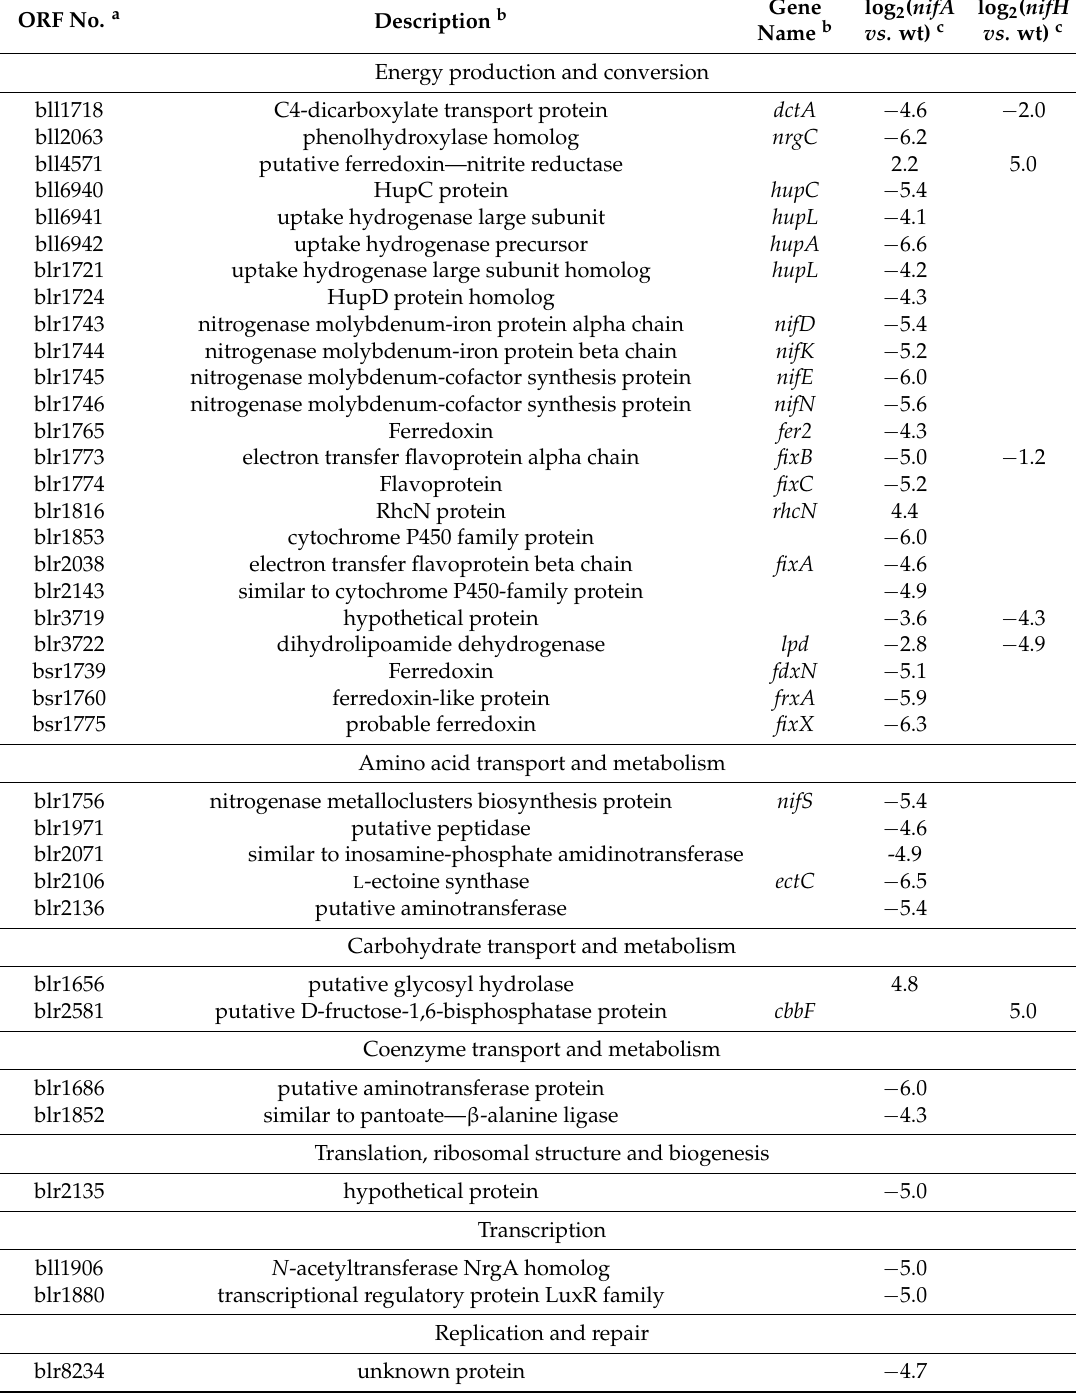
Table 3. List of the 137 genes that showed high differential expression in nodules infected by a nifH and/or a nifA mutant strain when wild-type nodules were used as reference (abs[log 2 (fold-change)] > 4 and q -value < 0.01 in at least one of the two mutant